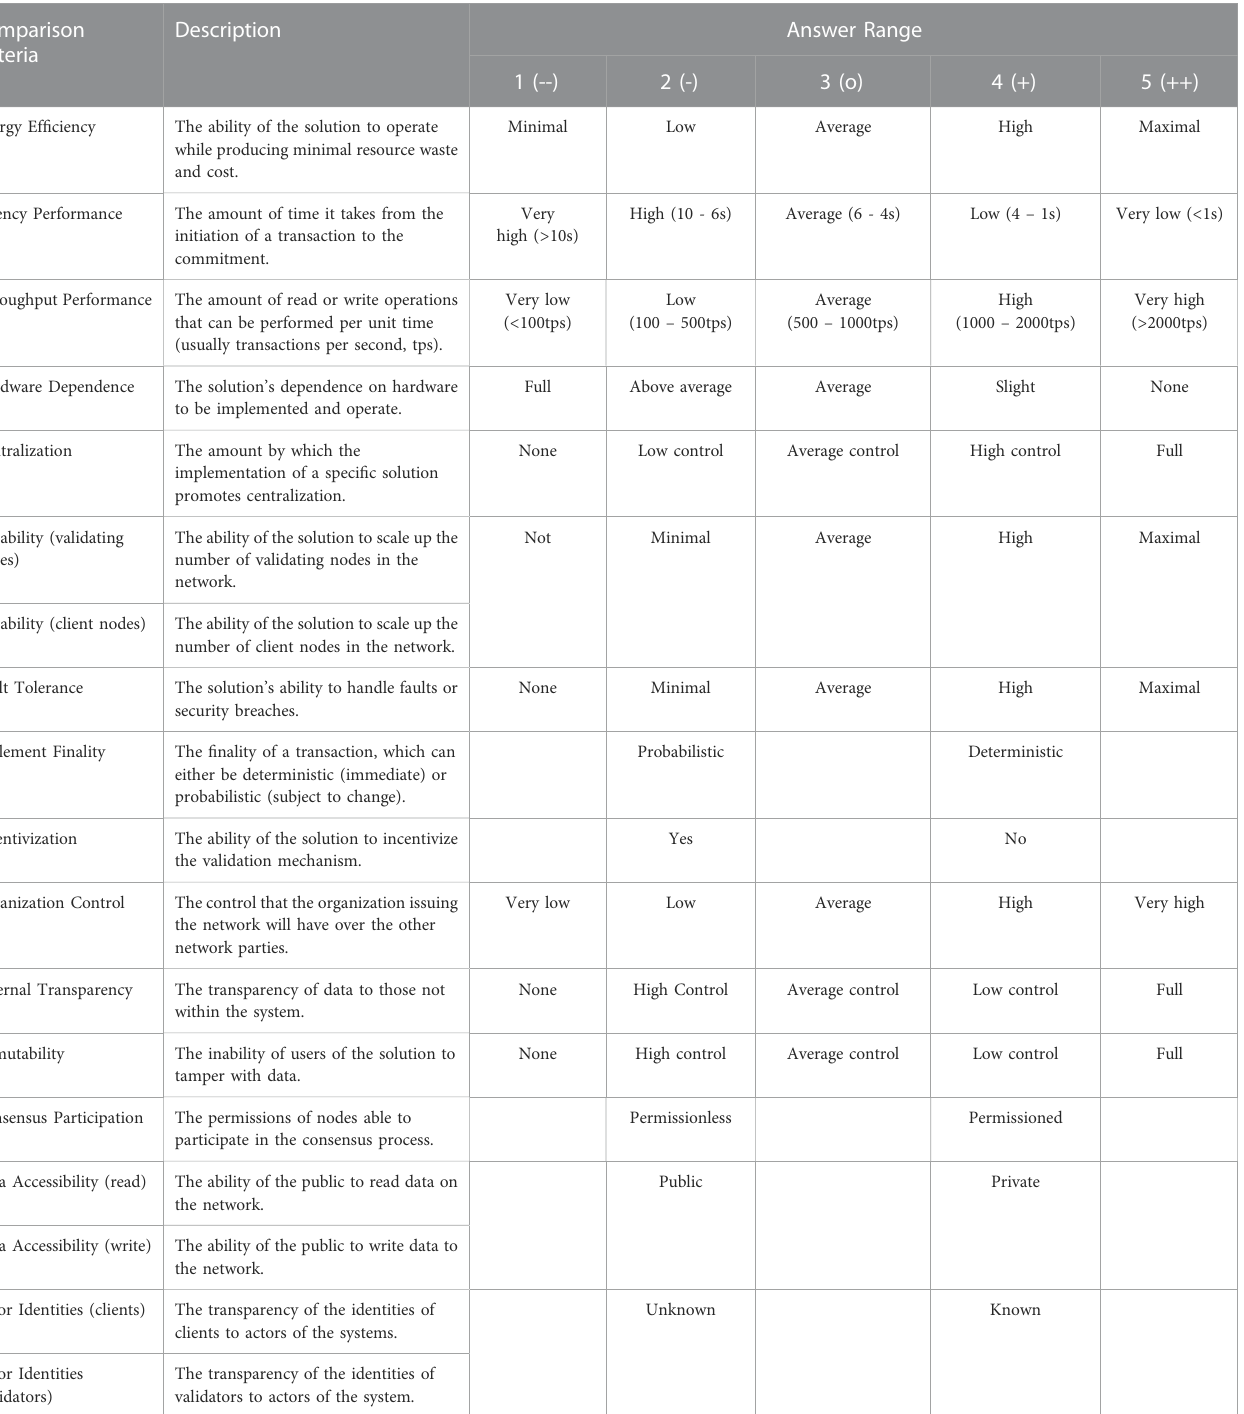
TABLE 7 Design Feature Comparison Criteria